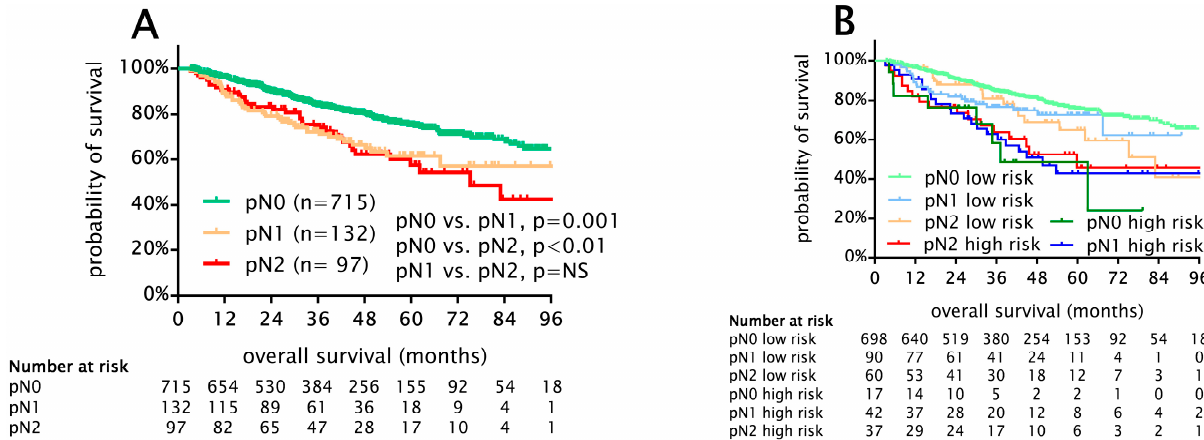
Figure 2. Kaplan–Meier survival analysis for OS in 944 patients with stage I-III NSCLC undergoing